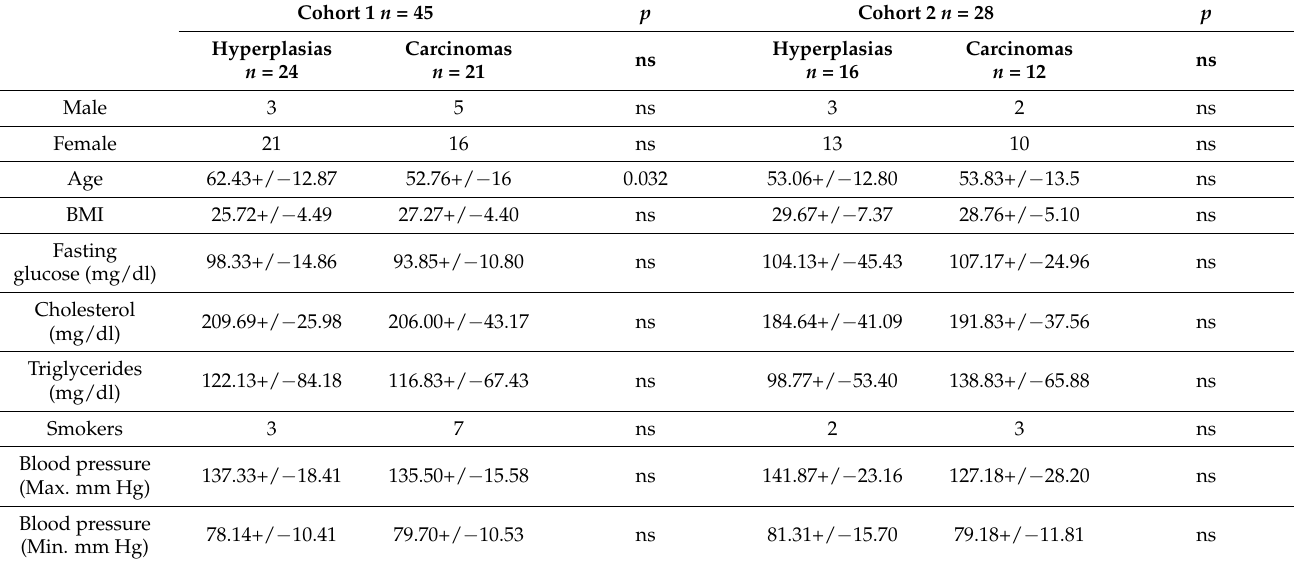
Table 1. Characteristics of the cohorts studied as classified by the histological diagnosis of the samples provided by the Hospital Universitario 12 de Octubre Pathological Anatomy Unit in accordance with the guidelines of the International Classification of Diseases for